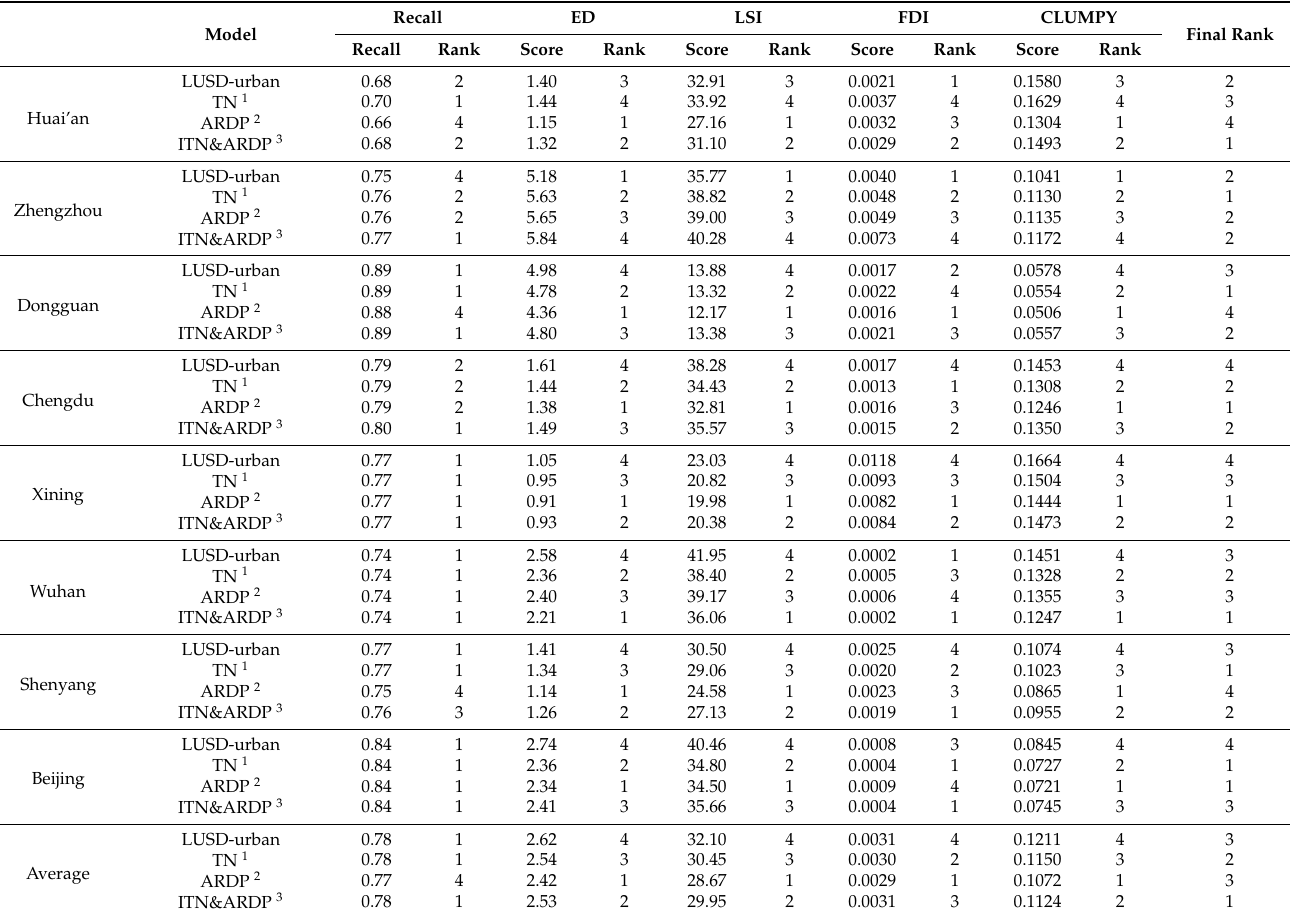
Table 2. Accuracy of the original and improved LUSD-urban